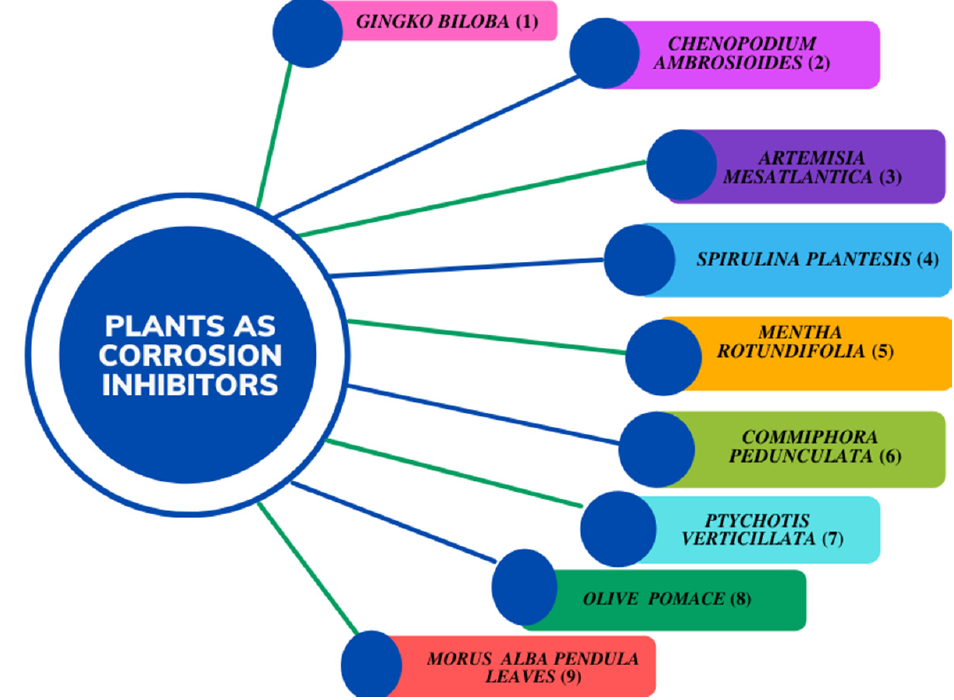
Figure 1. Plants that have been used as corrosion inhibitors: (1) [13,14], (2) [15], (3) [16], (4) [17], (5) [18], (6) [19], (7) [20], (8) [21] and (9) [22].